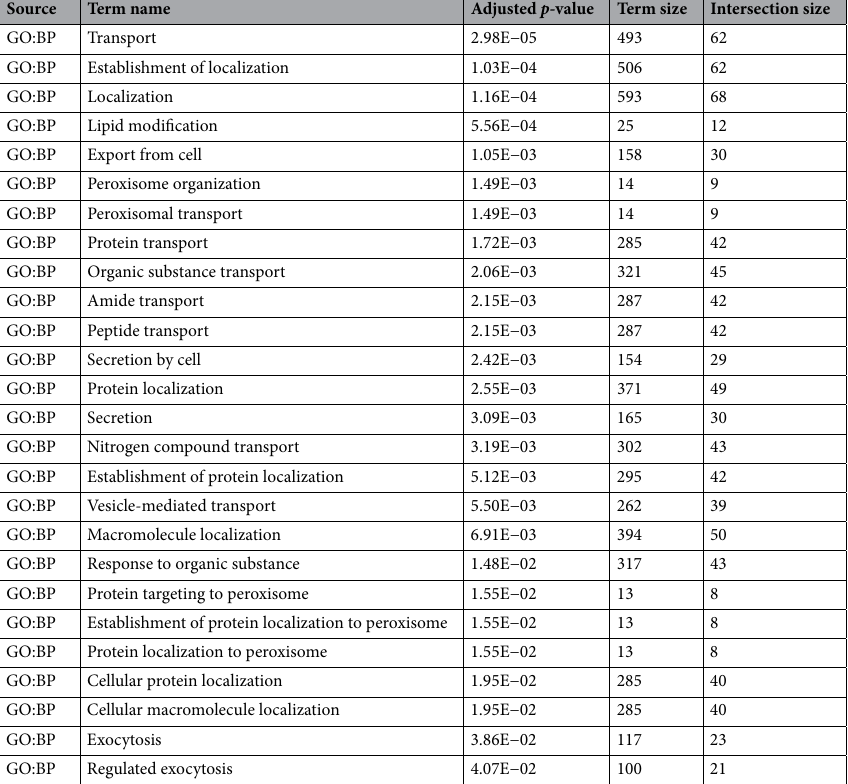
Table 2. GO biological processes associated with antagonist (haloperidol and sulpiride) treatment as determined by PCA. Proteins featuring the 10% highest positive association with factor 1 in PCA were compared to a background of all 1462 differential proteins using the web-based platform g:Profiler ( p adj ≤